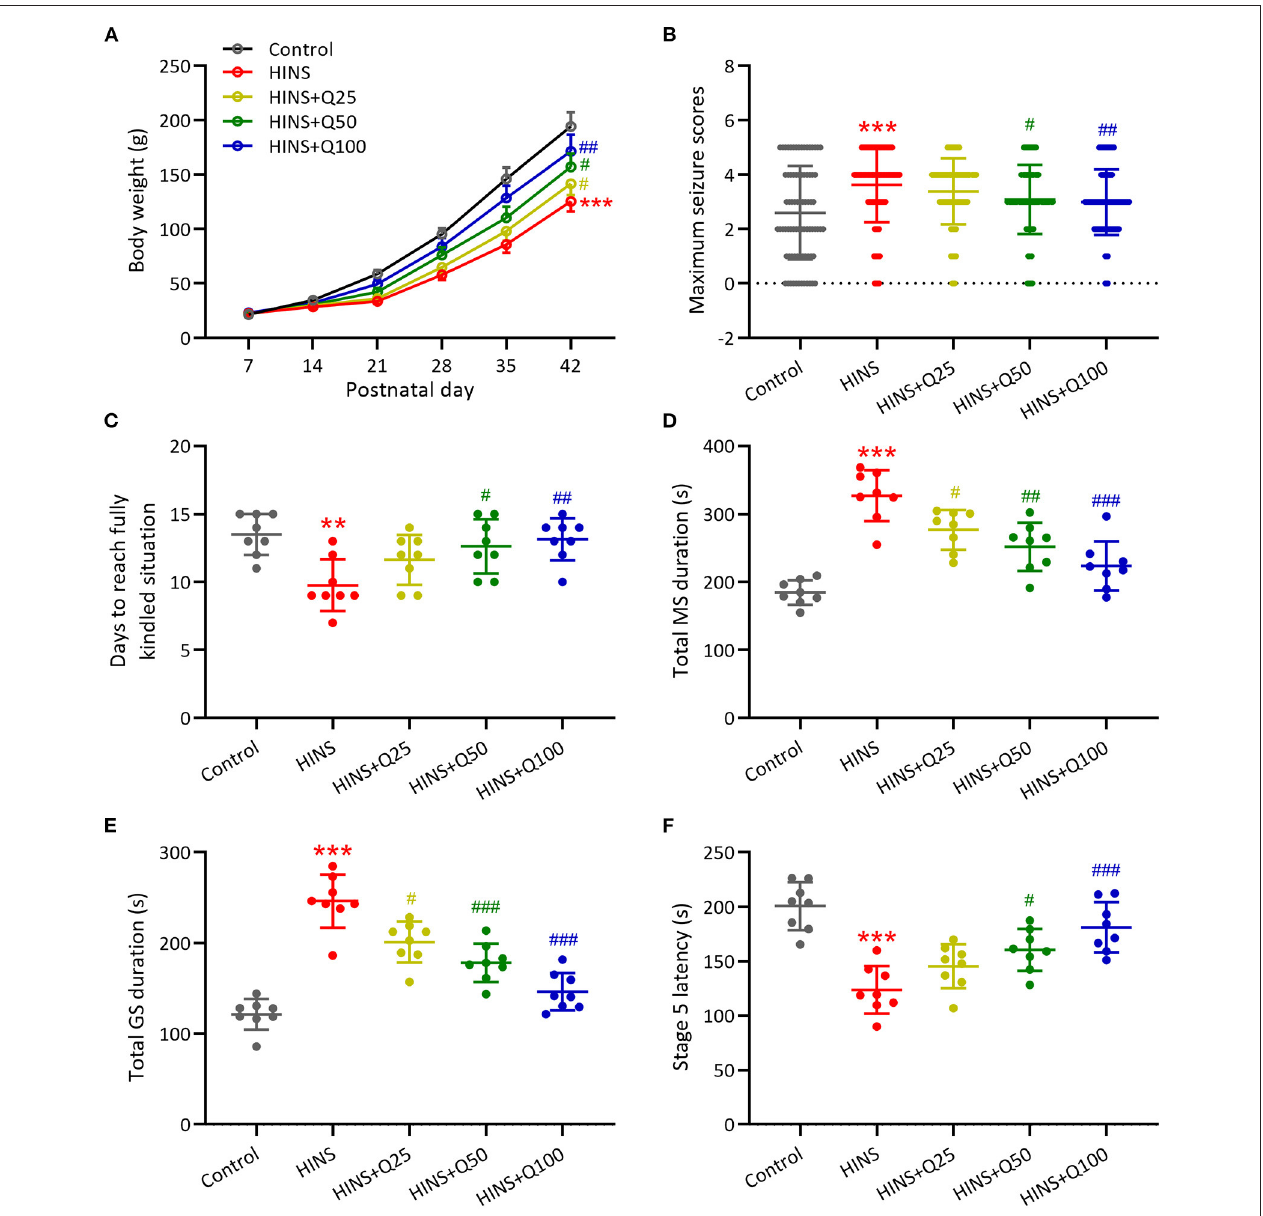
FIGURE 1 | Quercetin administration following HINS attenuated later-life seizure susceptibility in rats. (A) Effect of quercetin on body weight following HINS. (B) Maximum seizure stages during 20min after PTZ injections in different experimental groups. (C) The averaged days to reach fully kindled situation in different experimental groups. (D) Total MS durations were recorded in different experimental groups. (E) Total GS durations were recorded in different experimental groups. (F) Stage 5 latency were recorded in different experimental groups. Eight rats were used to recorded in each group. Mean ± SD. ** p < 0.01, *** p < 0.001 compared to control. # p < 0.05, ## p < 0.01, and ### p < 0.001 compared to